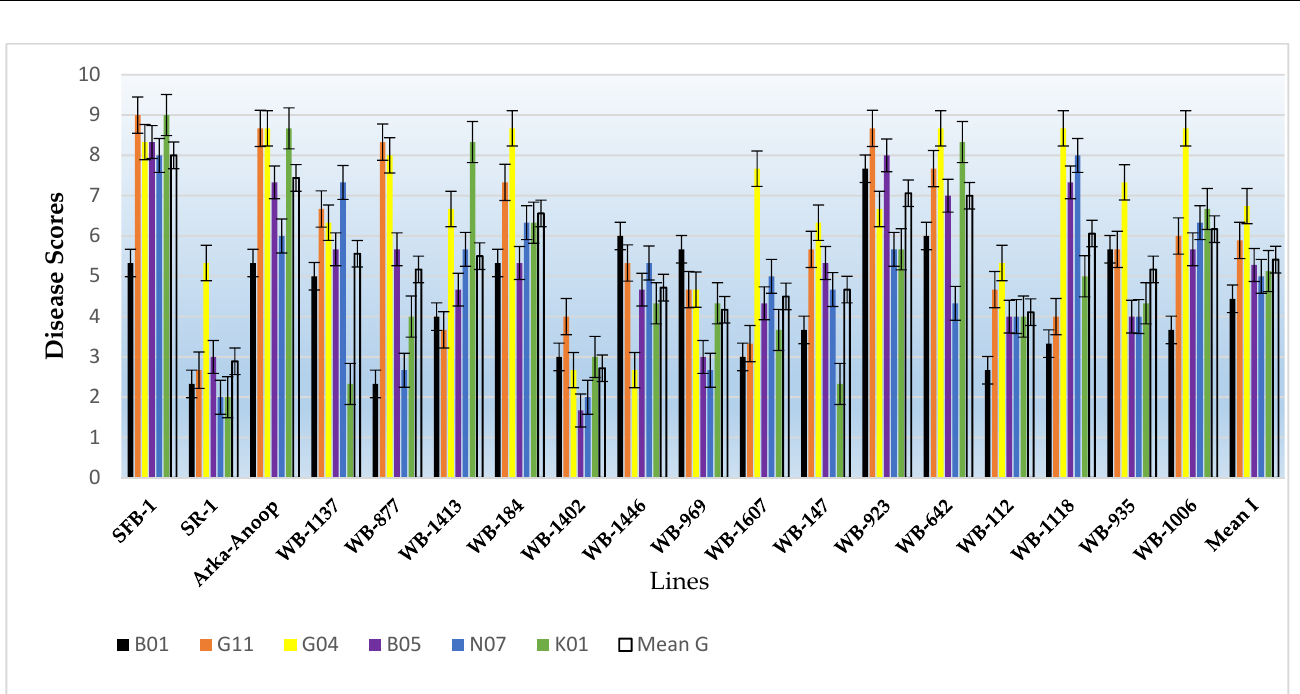
Figure 6. Graphical representation of pathogenicity of six isolates on eighteen bean lines. Mean I = mean disease scores by isolates. Mean G = mean disease scores on common bean lines.